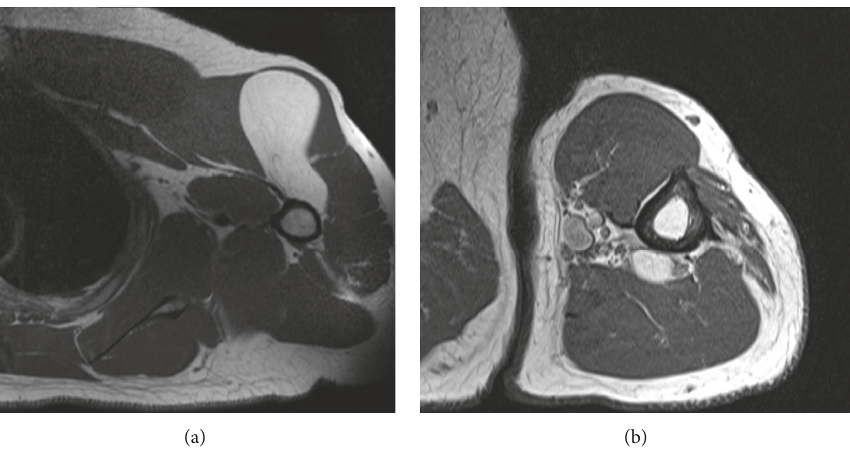
Figure 2: (a) Axial T1 MR of left shoulder with 12cm lipomatous tumor. Formula and expert observers predicted benign lipoma, while initial pathology was concerning ALT/WDL. Lack of MDM2 amplification with FISH confirmed a diagnosis of benign lipoma. (b) Axial T1 MR of the left arm with 2cm lipomatous tumor. Formula and expert observers predicted benign lipoma, which was later confirmed by lack of MDM2 amplification through FISH after initial pathology was concerning ALT/WDL.